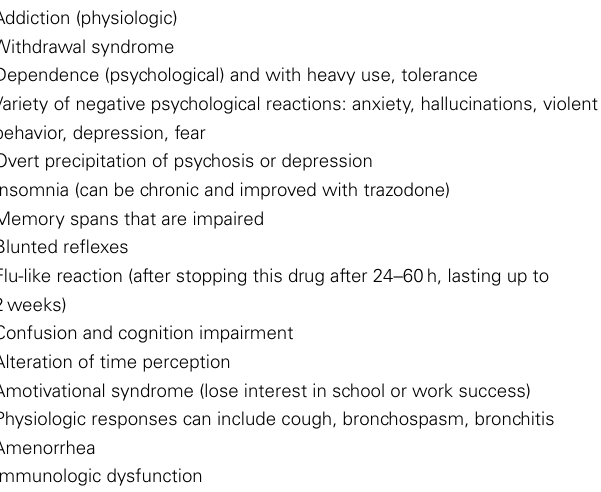
Table 4 | Potential adverse effects of marijuana a (see